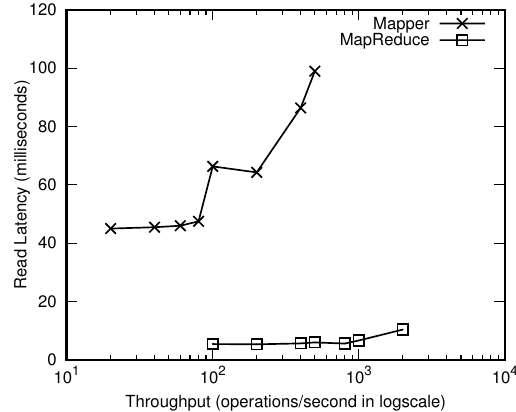
Figure 5. Mean delay of read operations.